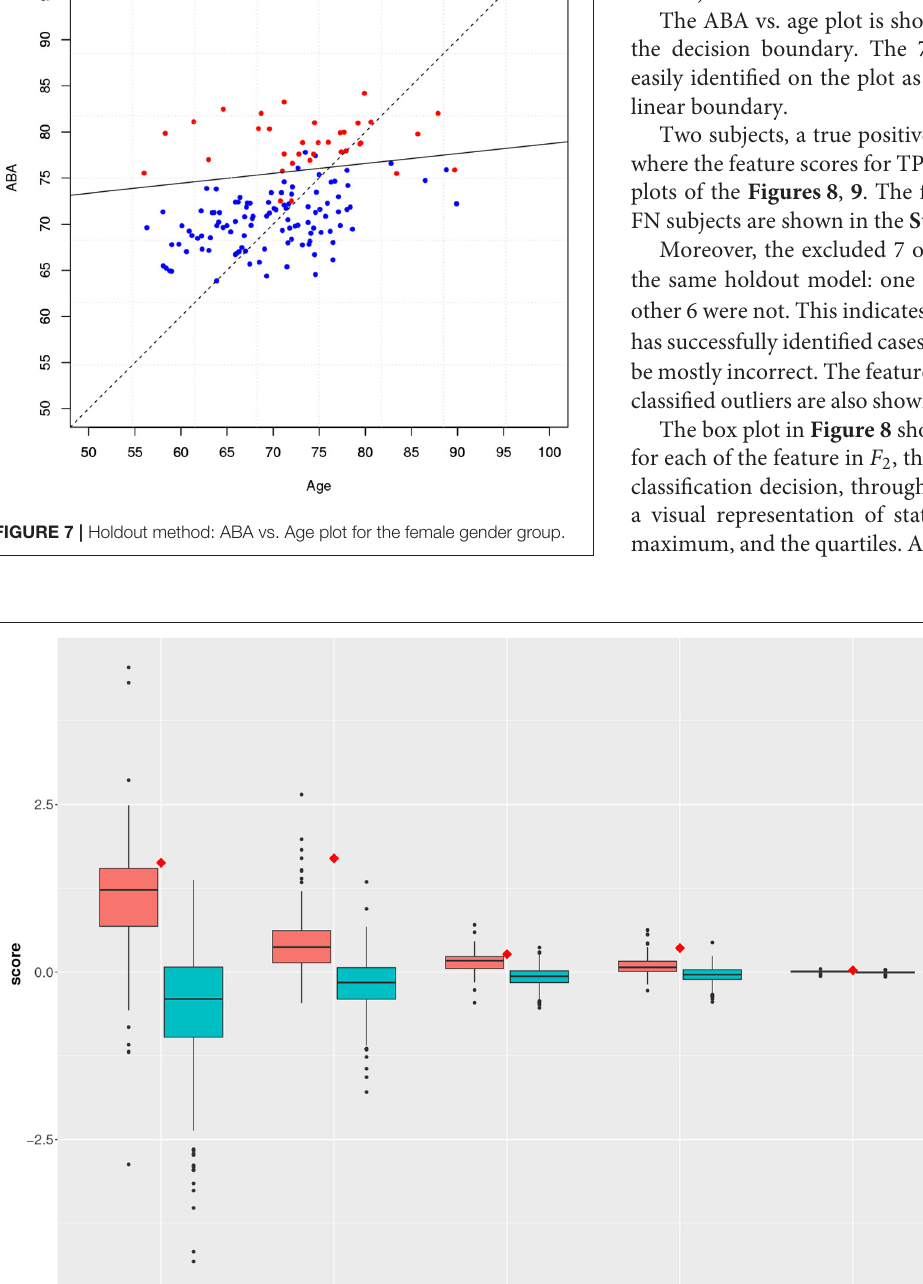
Frontiers in Neuroscience |